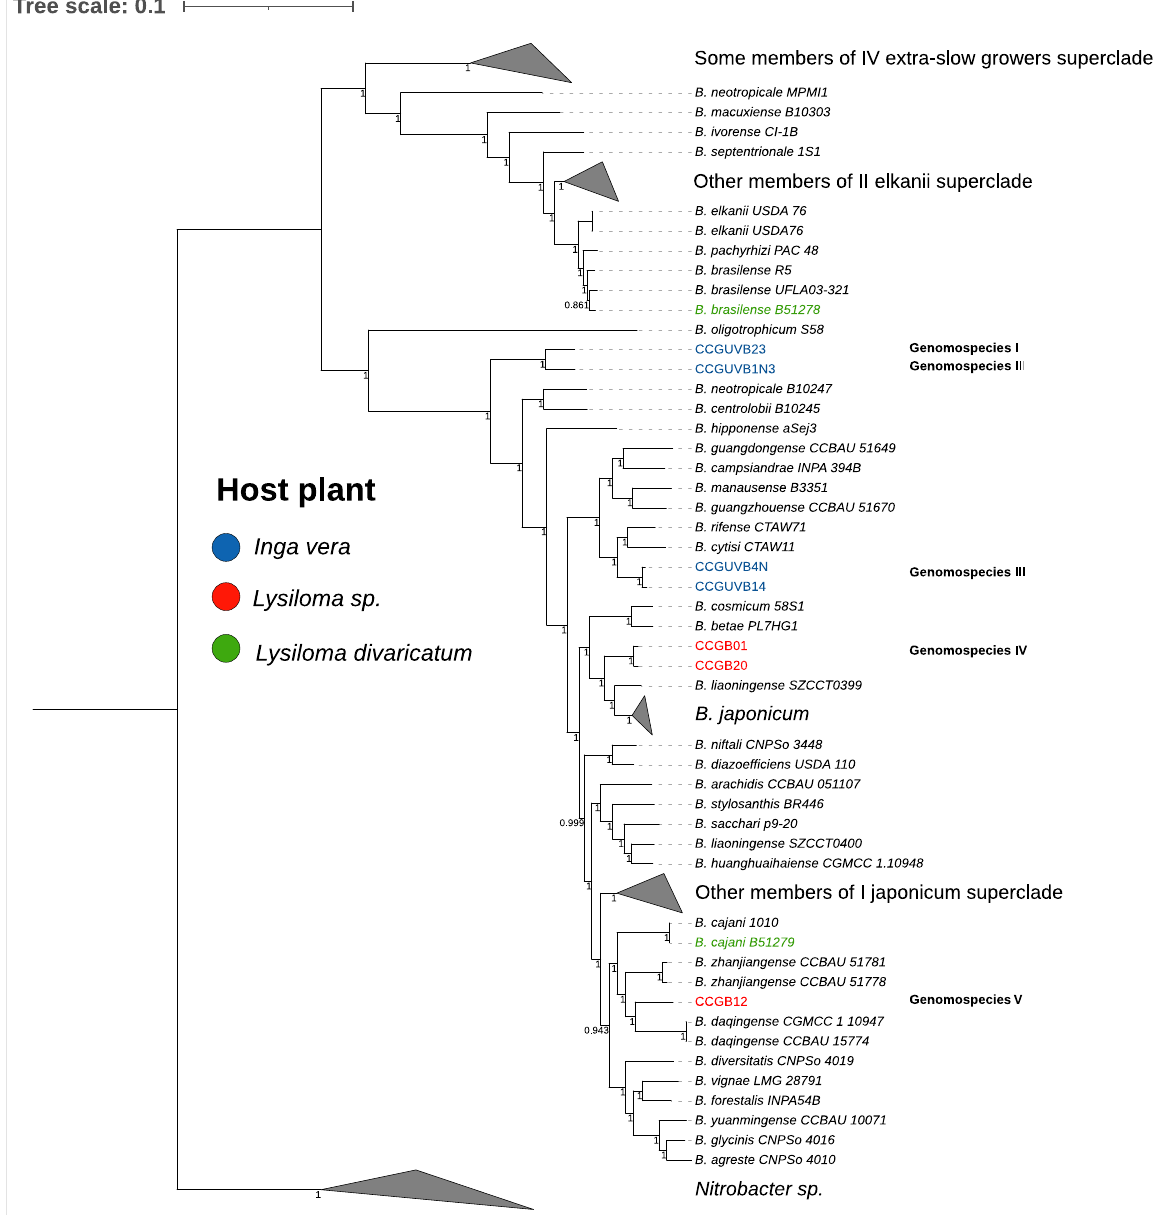
Figure 4. Species consensus phylogenomic tree based on 1,113 orthogroups of 101 genomes (Table S1). Support values correlate to the proportion of times that the bipartition is seen in each of the individual trees used to create the consensus tree. The scale represents substitutions per site. Seven Nitrobacter strains were used as an external group. Blue for Inga vera isolates, red for Lysiloma sp. isolates, green for L. divaricatum isolates.